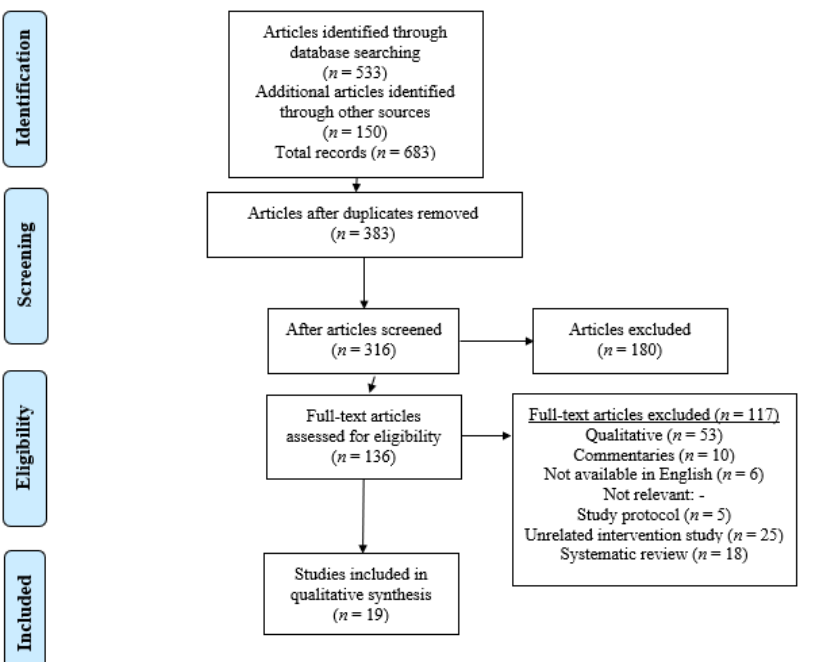
Figure 1. Flow diagram of the study selection process.